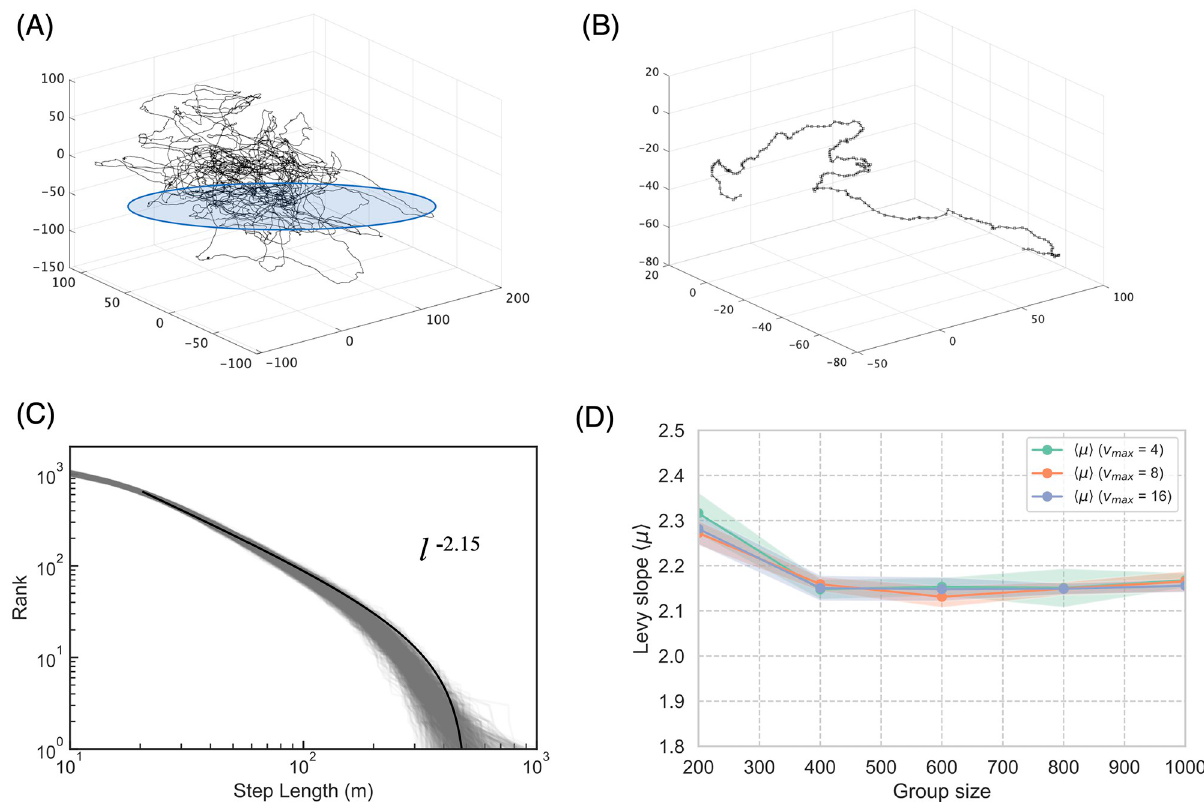
Fig 4. Le´vy walk on the center-of-mass reference frame. (A) Sample center-of-mass trajectory for 10000 steps. (B) Enlarged version of the blue-circle area (200 steps). The dots indicate individual steps. (C) Sample step-length l distribution for the mass-centered trajectories of 1000 agents. All l distributions obey the truncated power law distribution P ( l ) * l − μ . The average Le´vy slope μ is 2.15. (D) The average μ with respect to group size for various velocity v max